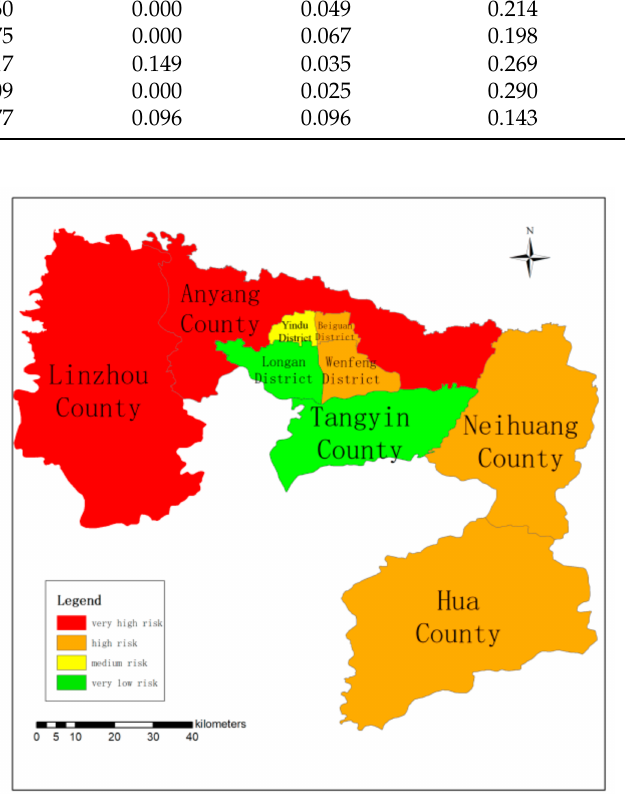
Figure 6. Distribution map of flood disaster risk assessment in Anyang